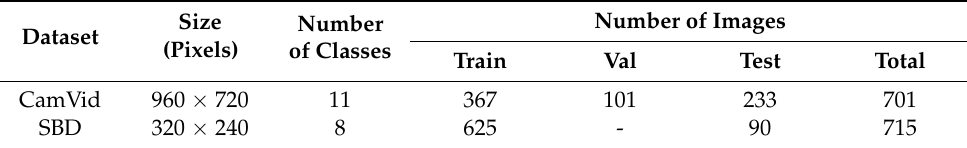
Table 2. Descriptions of experimental datasets (Train, Val, and Test refer to training, validation, and testing images, respectively).